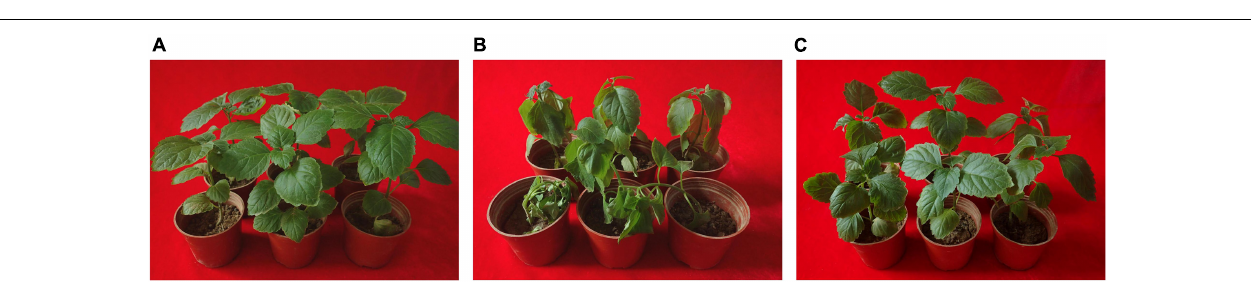
FIGURE 7 | Pathogenicity test of mutant Pa82-87-1 on patchouli plants (at 5 days post-inoculation). (A) Plants mock-inoculated with sterile water (negative control); (B) Plants inoculated with wild type strain Pa82 (positive control); (C) Plants inoculated with mutant